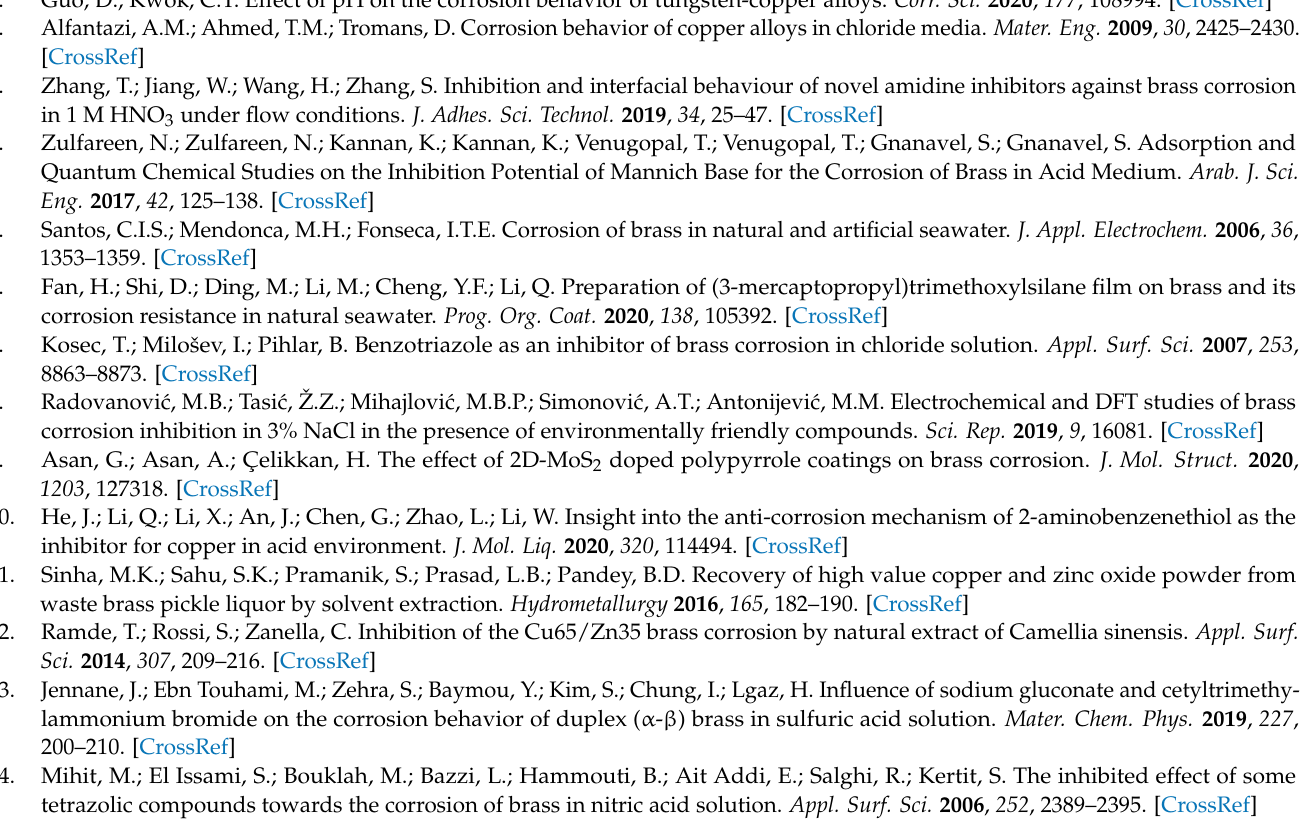
Table S3: Calculated capacitance values in the presence of different concentrations of corrosion inhibitors; Figure S1: Adsorption isotherm fitting for various models using the potentiodynamic polarization data at 25 ◦ C Table S4: XPS Spectra comparison for inhibited treated brass; Figure S2: UV-vis spectroscopy of P2T inhibited immersion solution in 0.5 M H 2 SO 4 solution without the presence of brass (citation: